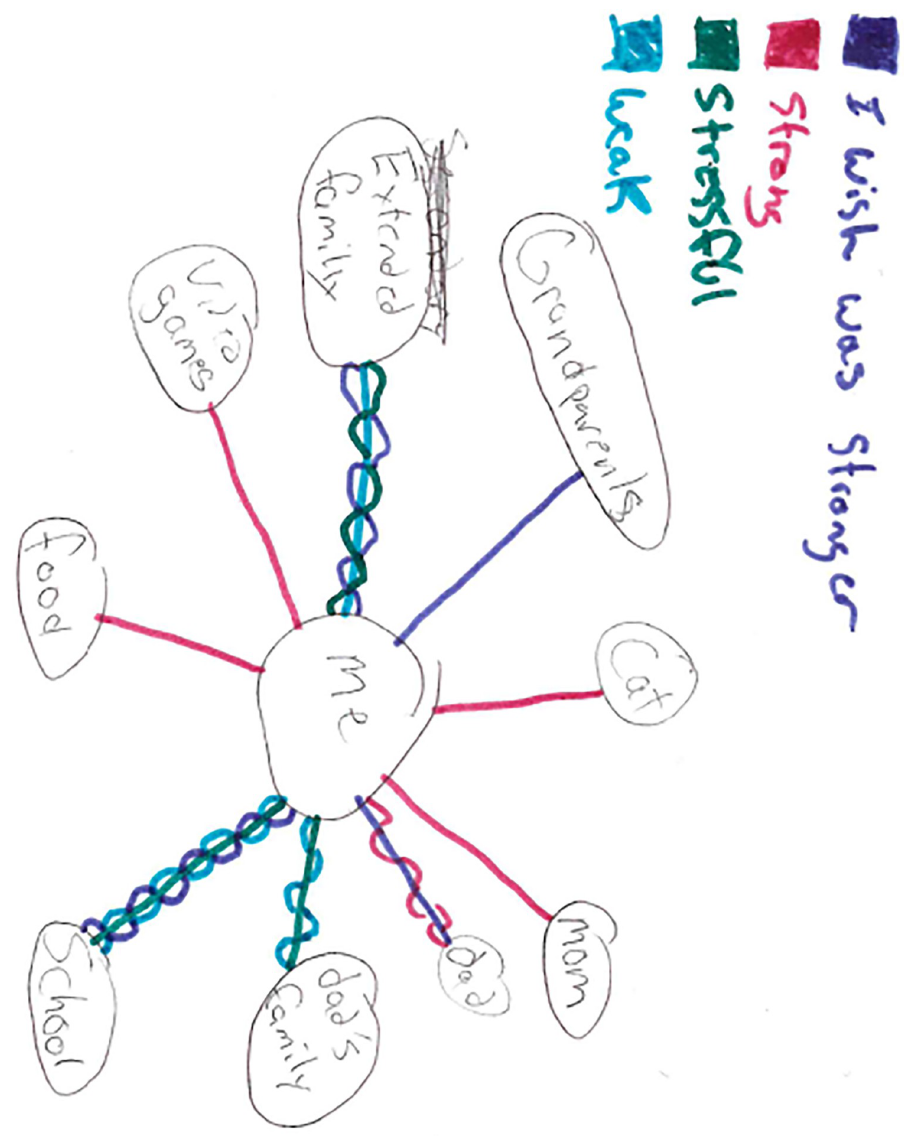
Fig 3. Ecomap depicting fractured